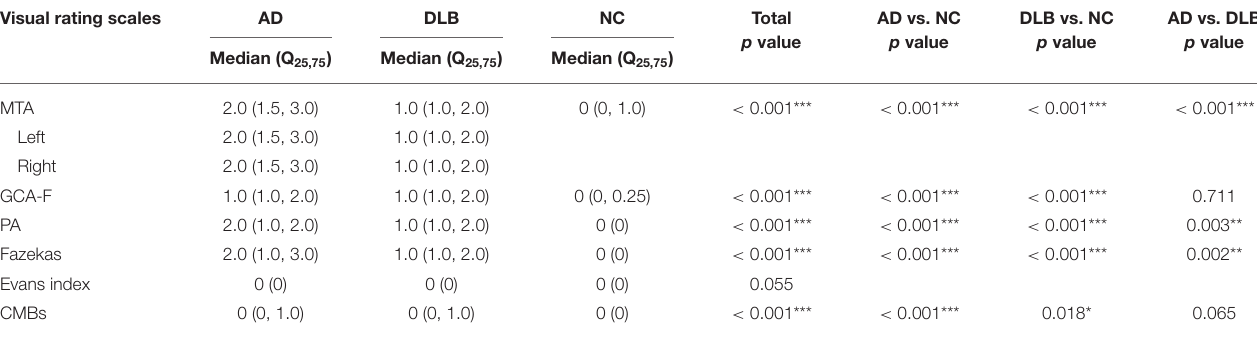
TABLE 2 | Neuropsychological assessment scores and MRI visual rating scales of each subject group. Visual rating